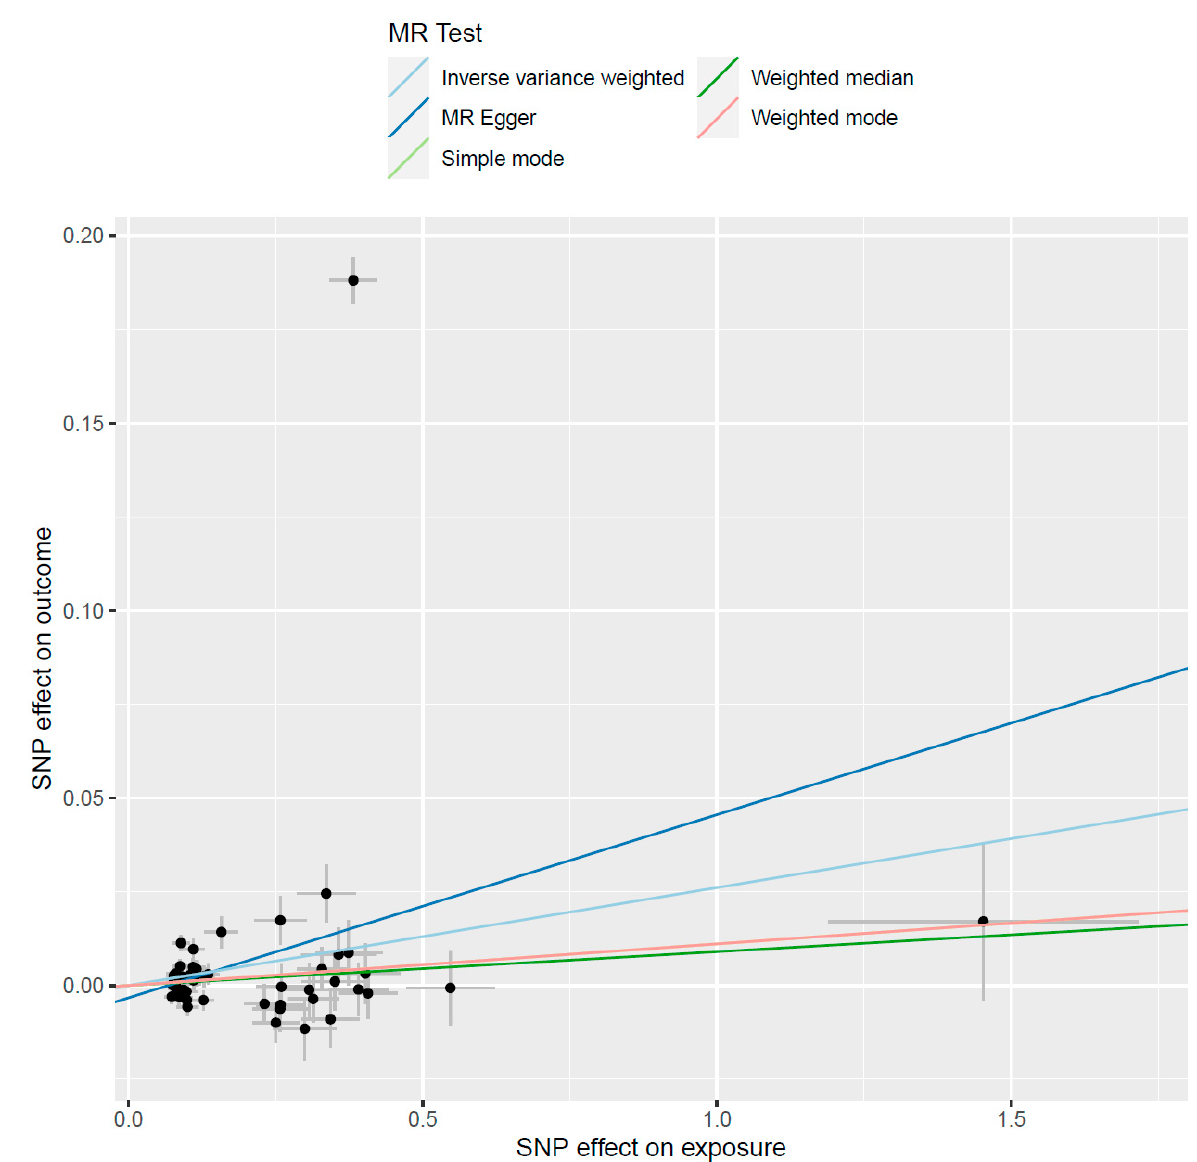
Figure 3. Causal effect of genetic risk of gout on alcohol consumption. The black circles represent the effect of individual SNPs on outcome and exposure, while the grey lines show their standard errors.